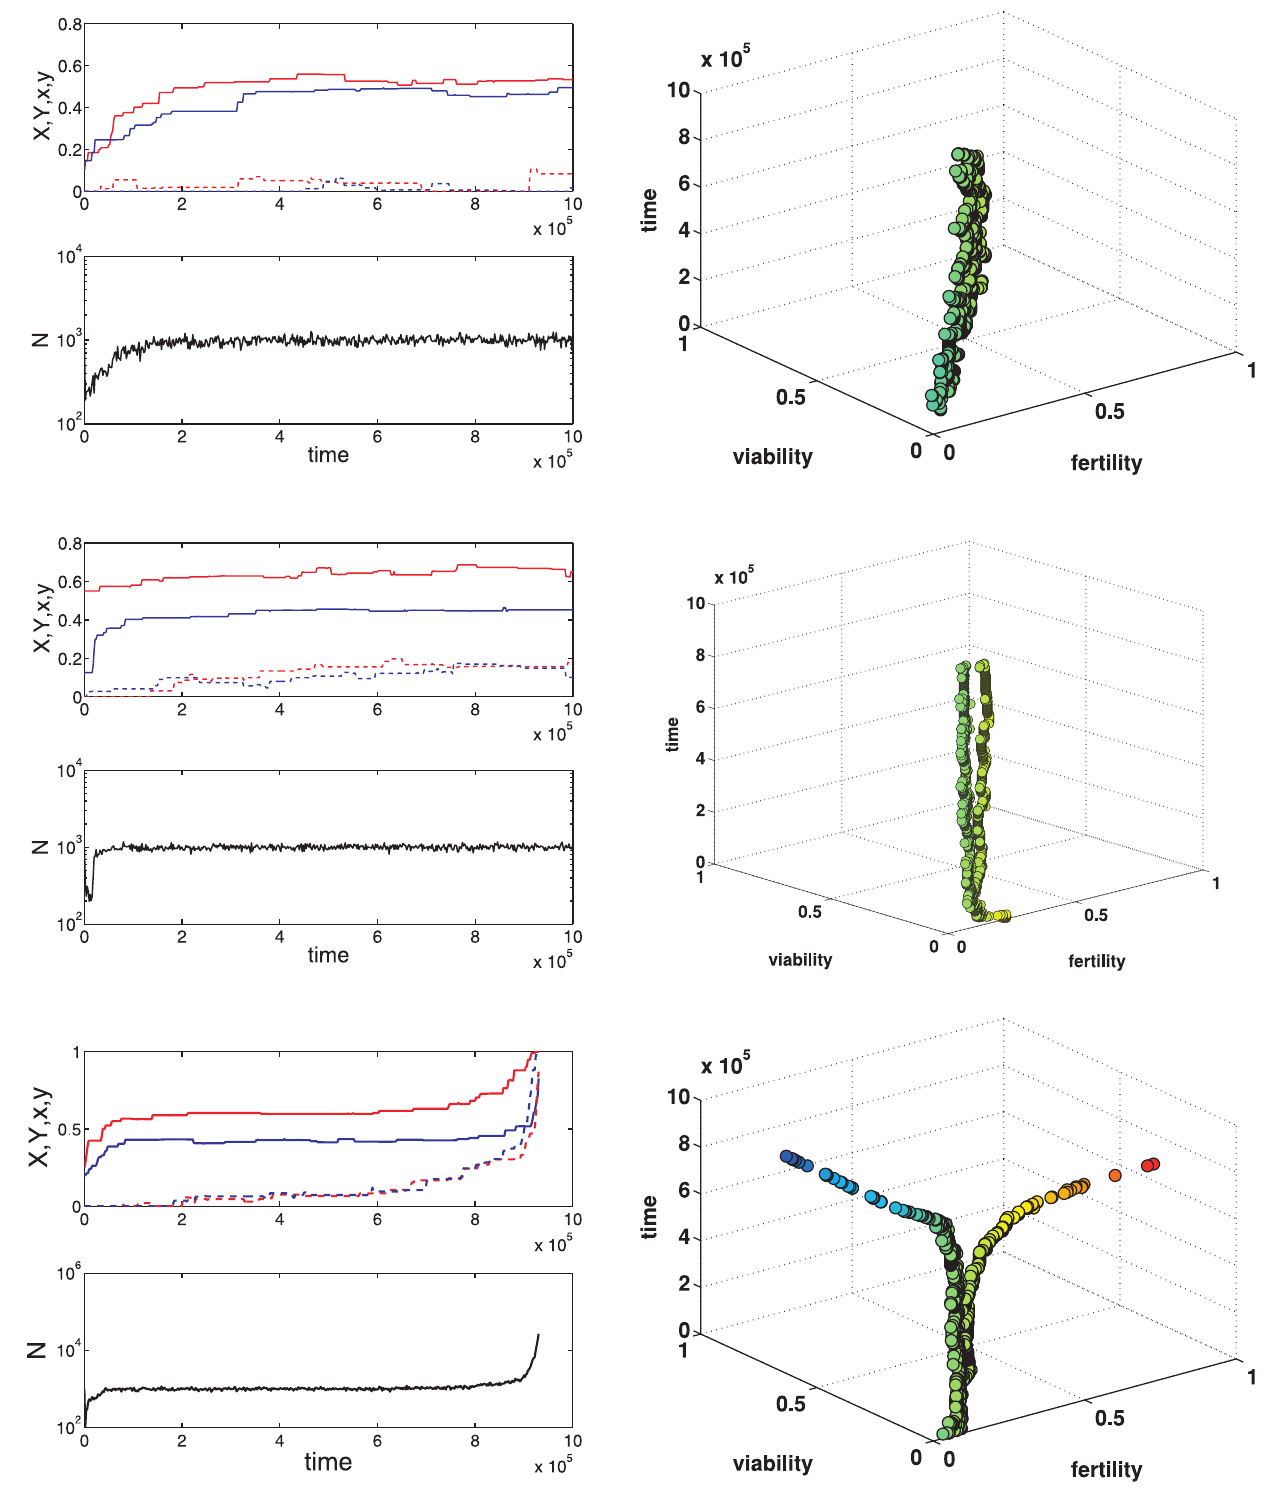
Figure 2. Examples of the model dynamics with S ~ 32 , p ~ 1 = 4 . First column: the dynamics of the main (solid lines) and modifier (dashed lines) allelic effects and the population size. Second column: fertility and viability for pro-some and proto-germ cells; each cell in the population is represented by a circle. Data are saved every 2000 generations. First row: a ~ b ~ 1 : 0, s ~ 0 : 5, m ~ 10 { 5 . Second row: a ~ b ~ 2 : 0, s ~ 0 : 5, m ~ 10 { 5 . Third row: a ~ b ~ 2 : 0, s ~ 2 : 0, m ~ 10 { 5 .